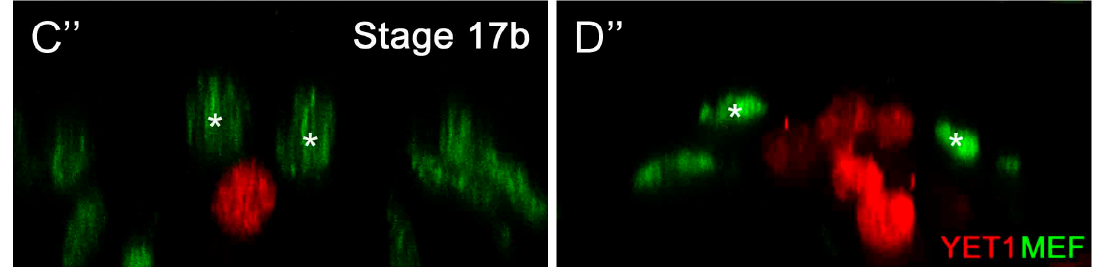
Figure 4. Amnioserosa cells remain at the midline in late stage src42A E1 embryos. ( A–B’ ) In wildtype embryos, the amnioserosa (red) is present at stage 16 ( A ) but has internalized and undergone apoptosis by the end of embryogenesis (stage 17, A’ ). In src42A E1 mutants, amnioserosa cells persist in the posterior region of the embryo even at late stages ( B–B’ ; arrowheads identify example amnioserosa cells; brightly red labeled cells in left of B’ are part of the midgut). The nuclei of amnioserosa cells are labeled with α Hindsight (HNT, red). The CB nuclei (and somatic muscle nuclei) are labeled with α MEF (green). Posterior of the heart is to the right. Calibration: 25 microns. ( C–D” ) Transverse sections through the heart and amnioserosa tissue of wildtype and src42A E1 mutant embryos. In wildtype embryos, migrating CBs (green, asterisks) move dorsally and eventually over the amnioserosa cells (red; C–C” ). Following migration, no amnioserosa cells are between the CBs; any remaining cells have been internalized ( C” ). In contrast, late stage src42A E1 embryos are characterized by persistent amnioserosa cells at the midline ( D–D” ). Despite having the rounded shape characteristic of cells undergoing apoptosis, the amnioserosa cells do not internalize, but remain along the midline where the heart tube usually forms. CB nuclei (and flanking muscle nuclei in C’ and C” ) are labeled with α MEF (green, asterisks), while YET1 marks the outermost amnioserosa cells (red). Dorsal is at the top. Calibration: 5